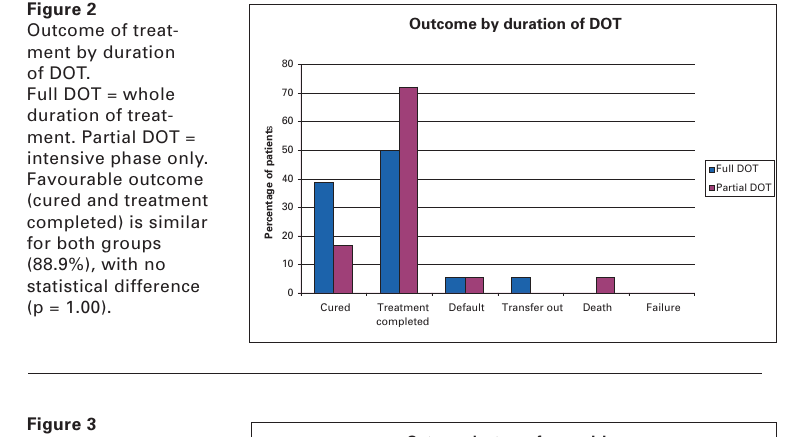
Figure 3 Outcome of treat- ment by type of